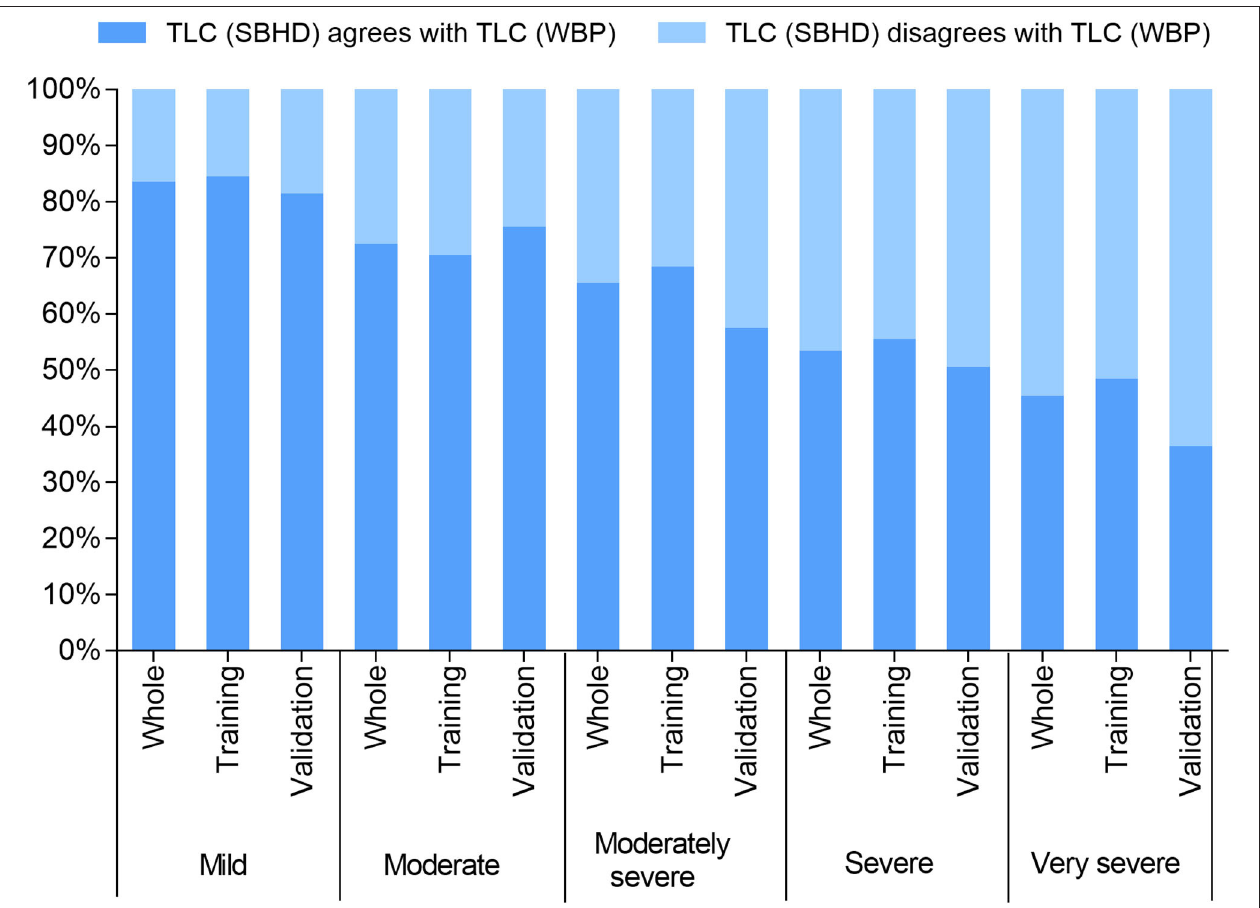
FIGURE 1 | TLC (SBHD) agrees with TLC (WBP): represents equivalent indication of normal lung volumes between the methods (i.e., > LLN); TLC (SBHD) disagrees with TLC (WBP): represents the volume determined using the SBHD method was abnormally low ( < LLN).